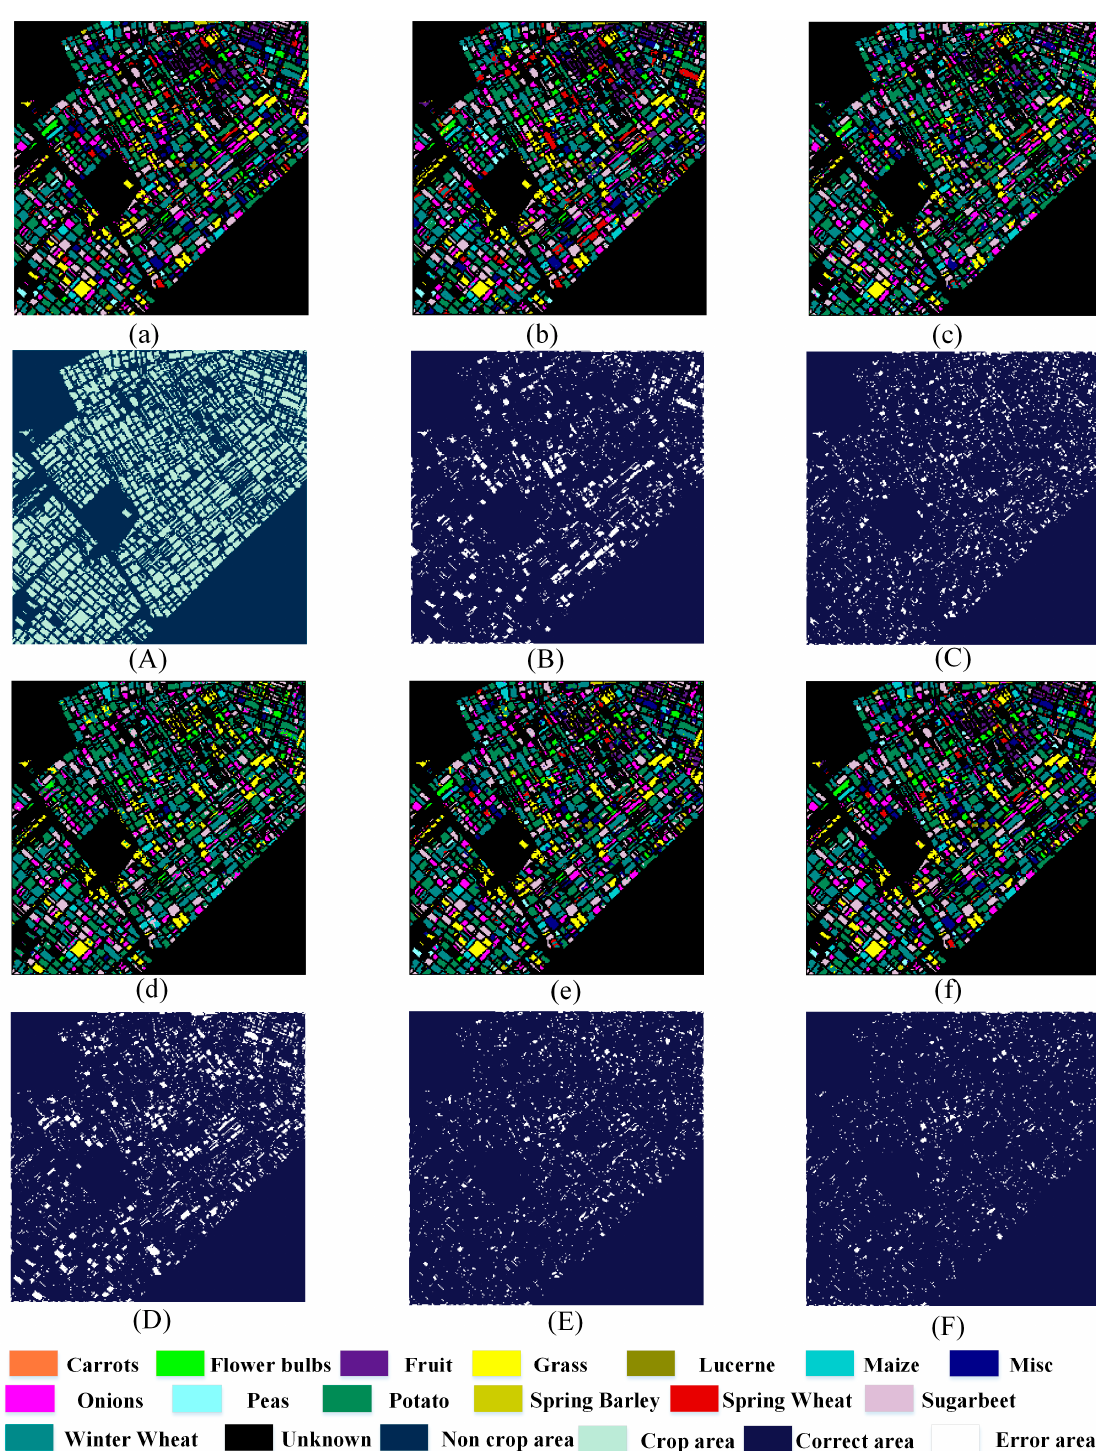
Figure 17. Classification results and ground truth map for the Flevoland site: ( a ) ground truth map, ( A ) crop area, ( b ) complex Wishart classifier, ( c ) Chen + CNN, ( d ) LSTM, ( e ) LLE + CNN, and ( f ) S-SAE + CNN. ( B – F ) are the error maps of (b–f).